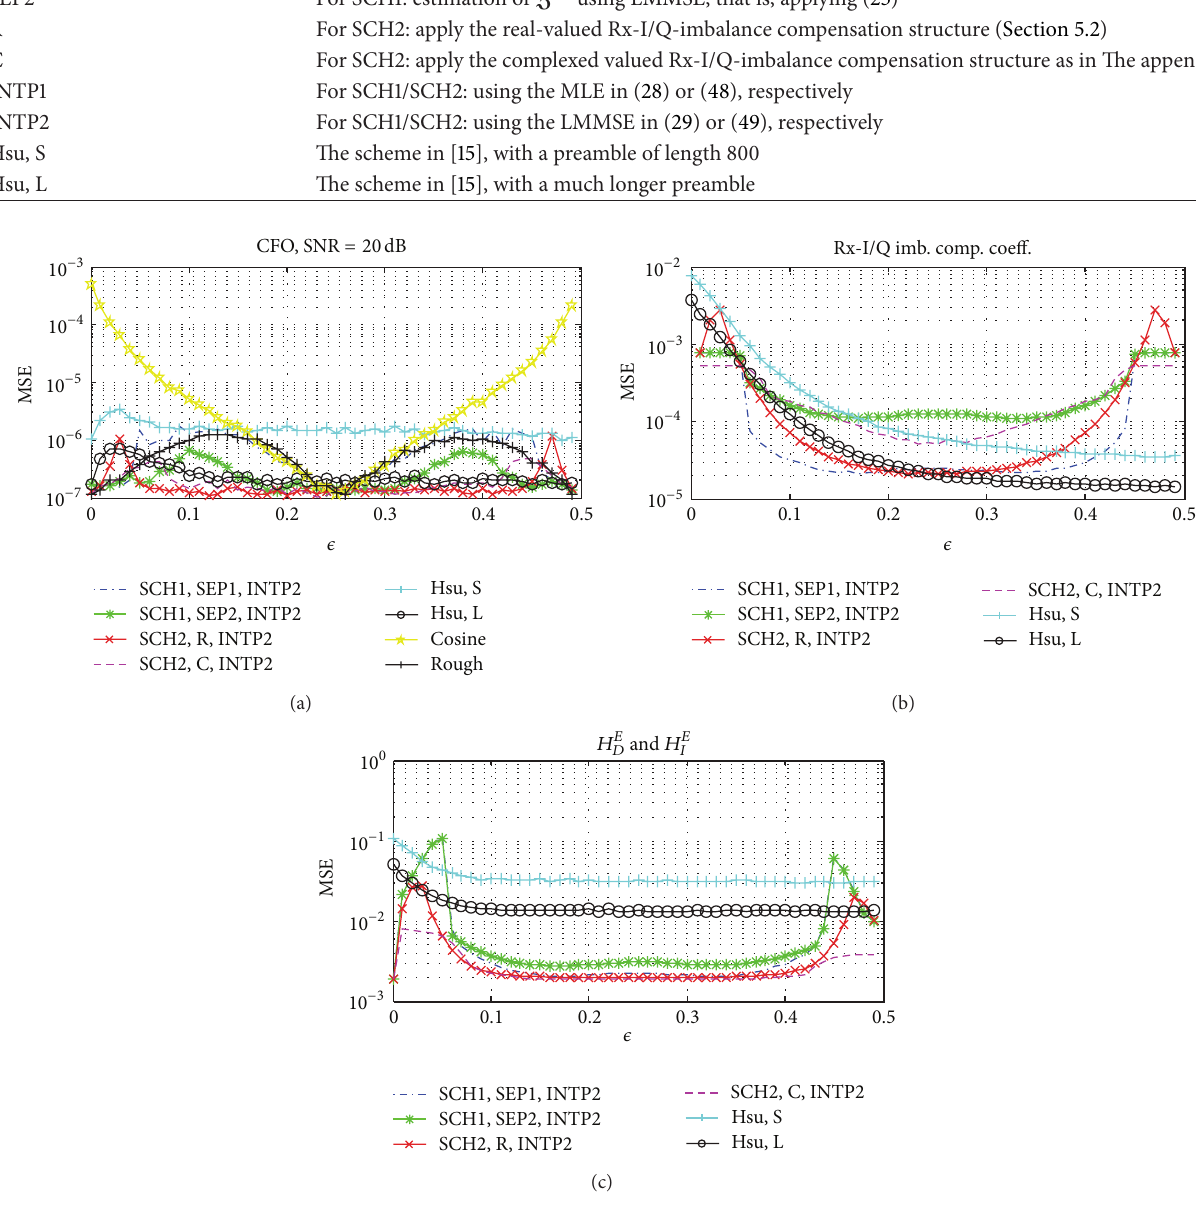
Figure 6: Estimation MSE as a function of 𝜖 with 𝑁 𝐼 = 1, 𝑁 = 256, and SNR = 20